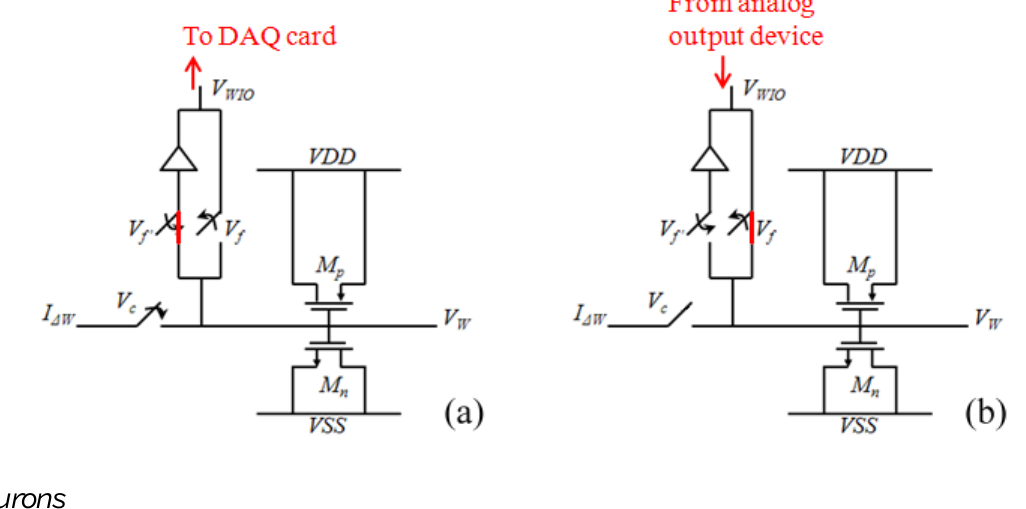
Figure 5. The weight unit. ( a ) Training phase; ( b ) Classifying